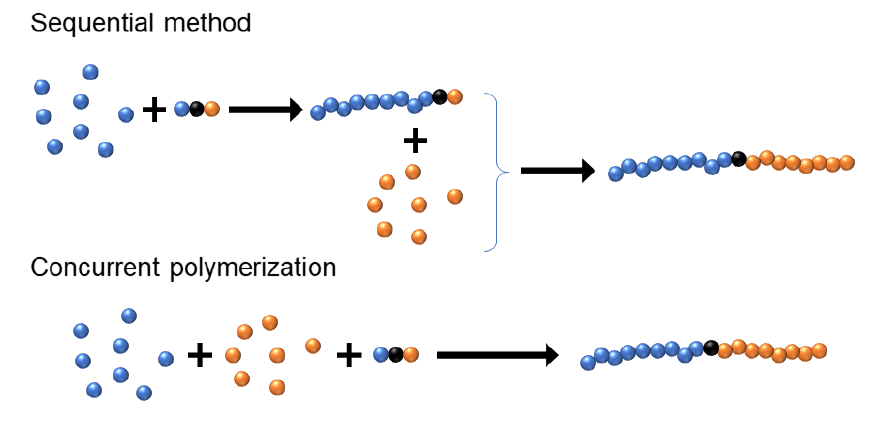
Figure 1. Procedures to synthesize a diblock